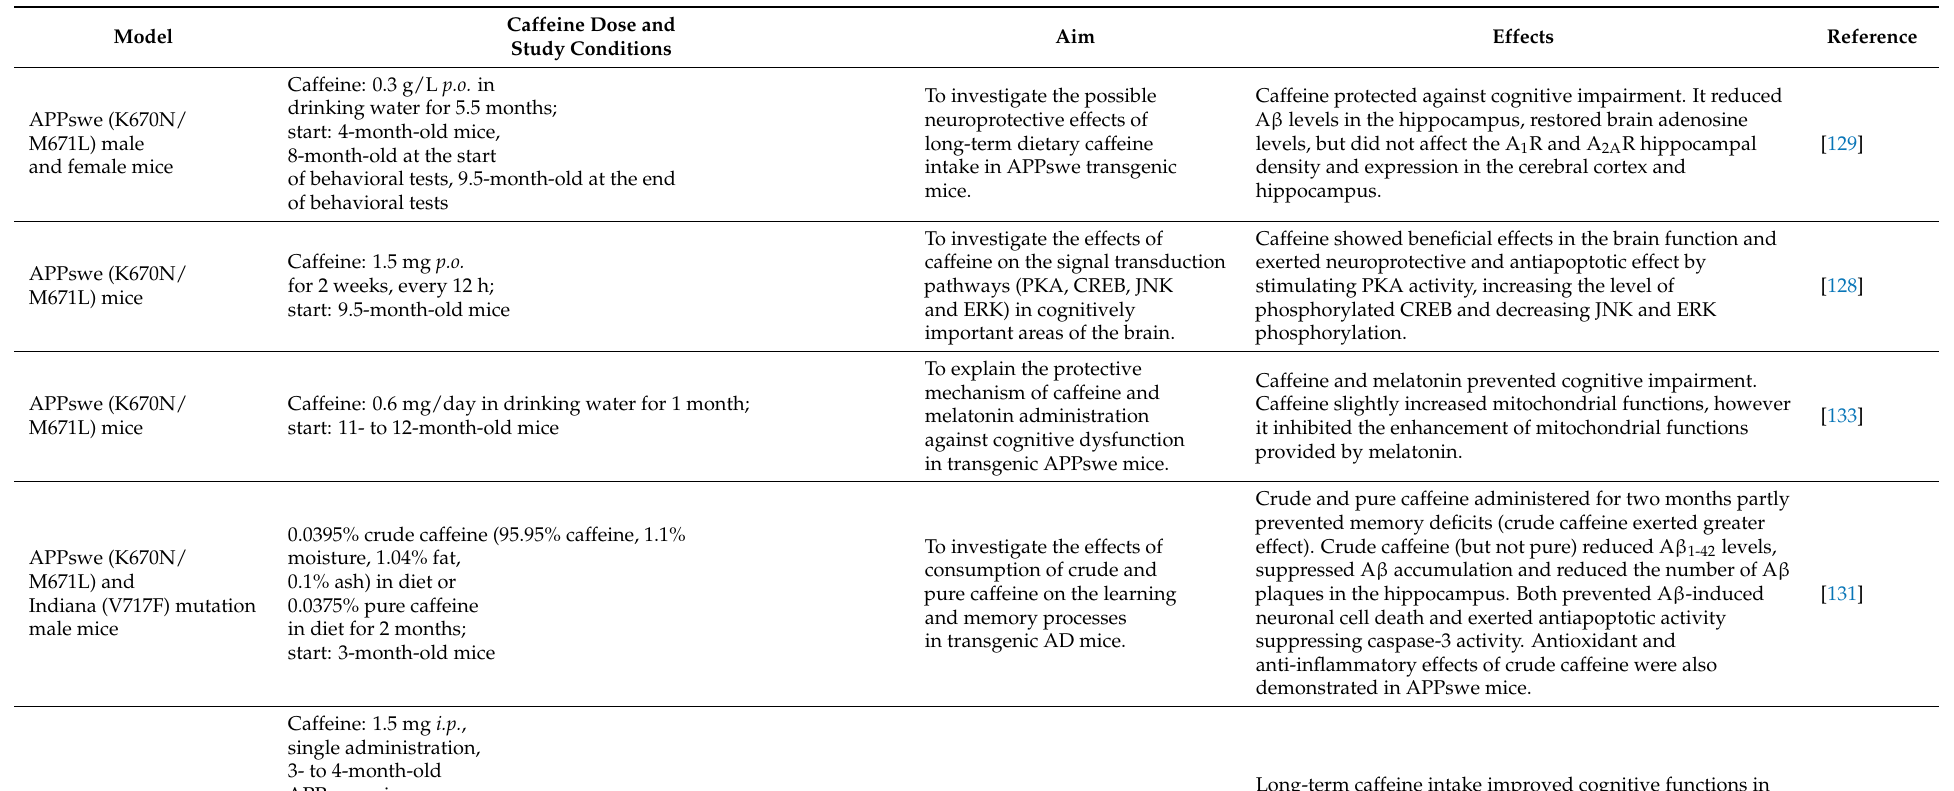
Table 1. Transgenic